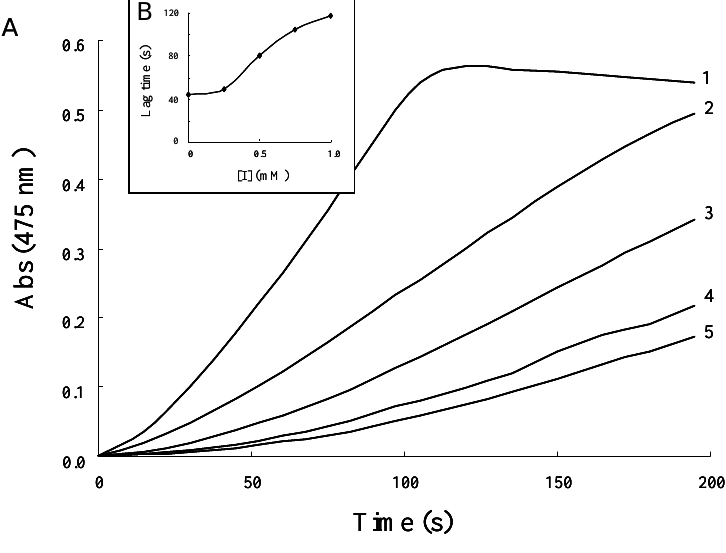
Figure 2. ( A ) Progress curves for the inhibition of monophenolase activity of tyrosinase by diflunisal. L -tyrosine was incubated with mushroom tyrosinase with or without diflunisal as described in the Experimental Section. The concentrations of diflunisal for curves 0–5 were 0 mM, 0.25 mM, 0.5 mM, 0.75 mM and 1.0 mM, respectively; ( B ) Relationship of the lag time with the concentration of